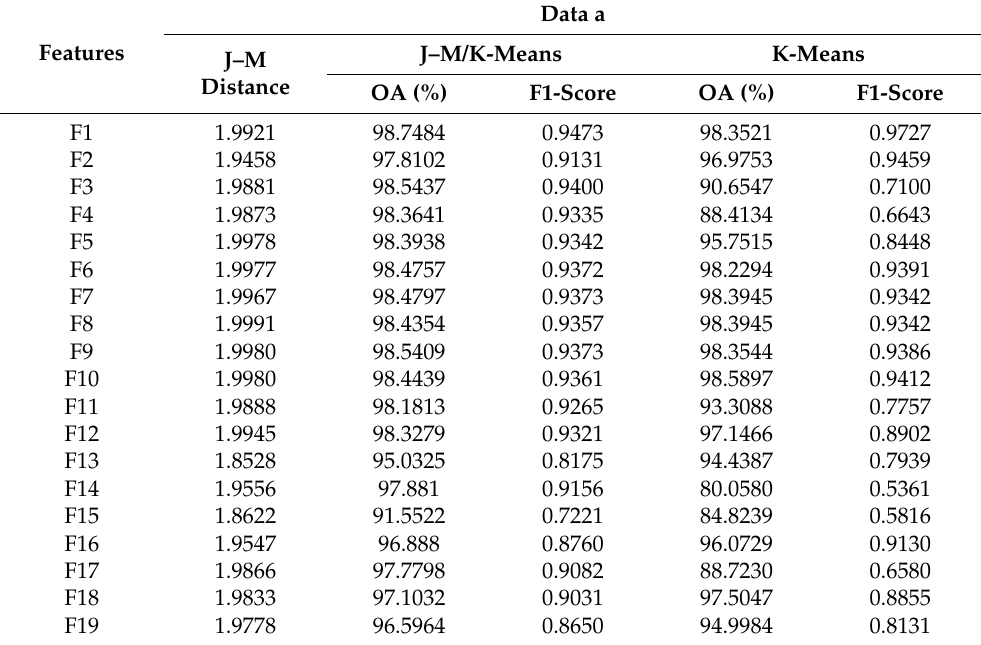
Table 2. Oil spill detection feature J–M distance and evaluation results of data a.